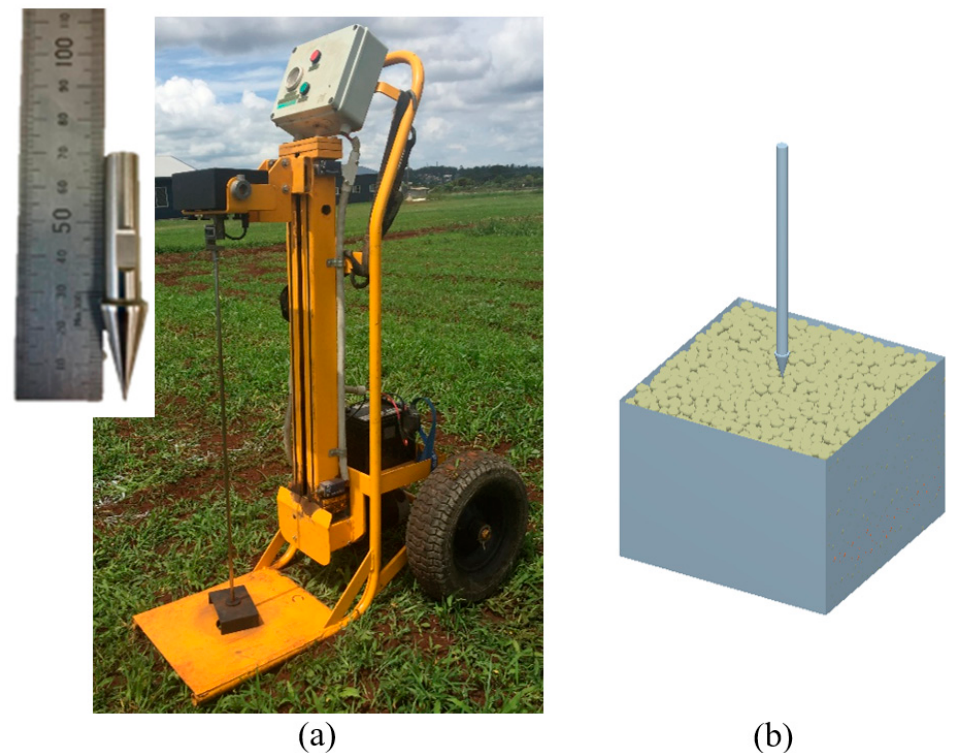
Figure 14. ( a ) Motorised cone penetrometer for in situ measurements, and ( b ) DEM cone penetration simulation used by Aikins et al. [41].